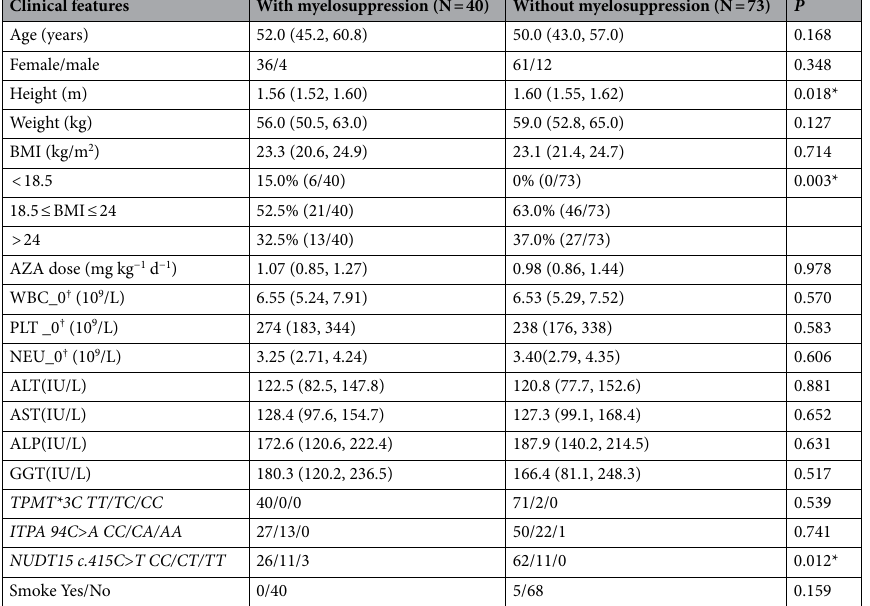
Table 1. Baseline characteristics of included subjects [median(IQR)]. BMI body mass index, AZA azathioprine, WBC white blood cell count, PLT platelet count, NEU neutrophil count, ALT alanine aminotransferase, AST aspartate aminotransferase, ALP alkaline phosphatase, GGT glutamyl transferase. † Represents the results prior to azathioprine treatment. *Significant ( P <